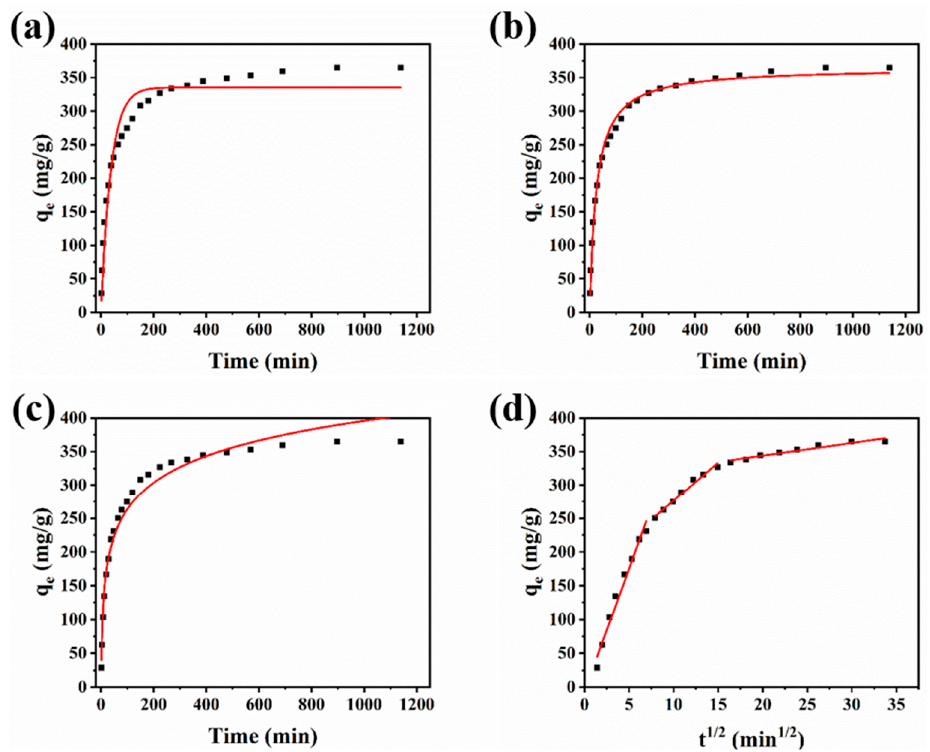
Figure 5. Adsorption kinetics of TC adsorbed by Alg-Cu@GO@MOF-525: ( a ) pseudo-first-order model, ( b ) pseudo-second-order model, ( c ) Elovich model, and ( d ) intra-particle diffusion model.